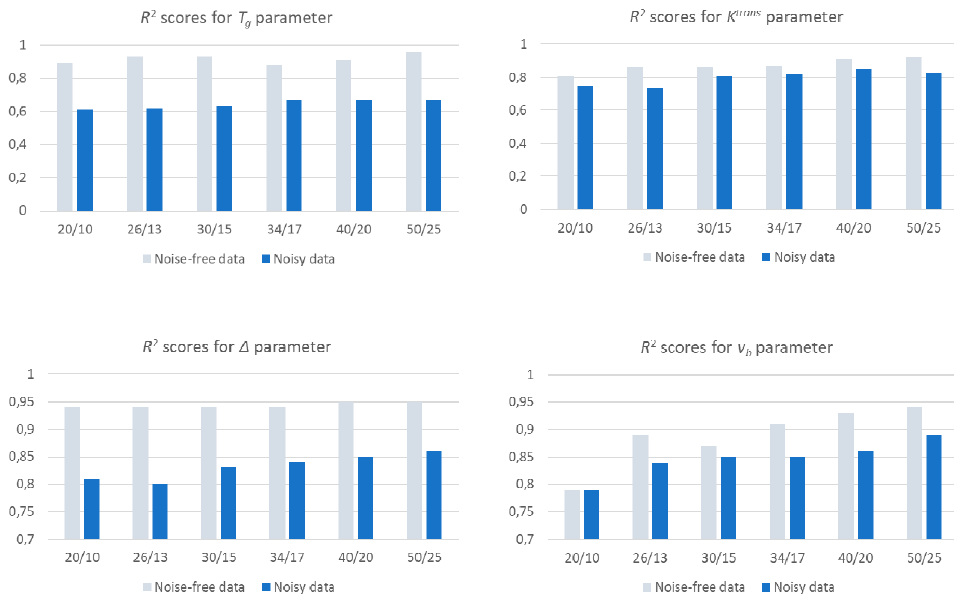
Figure 10. Determination coe ffi cients for two-compartment filtration model (2CFM) model parameters obtained for various network configurations (test set).